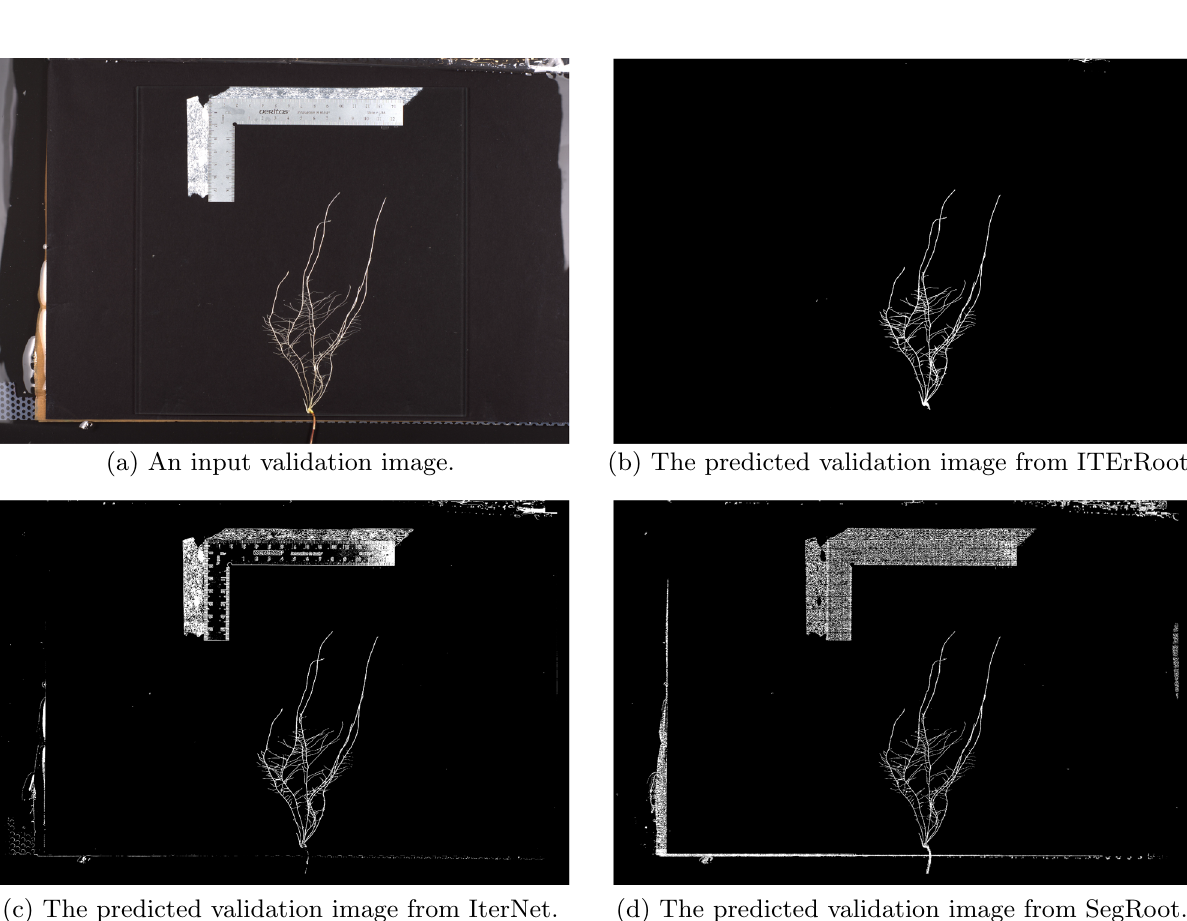
Figure 13. Output segmentations for an input image ( a ) from ( b ) ITErRoot ( c ) IterNet and ( d ) SegRoot. ITErRoot correctly identifies the ruler and surrounding imaging apparatus details as background, while IterNet and SegRoot incorrectly identify these as part of the root